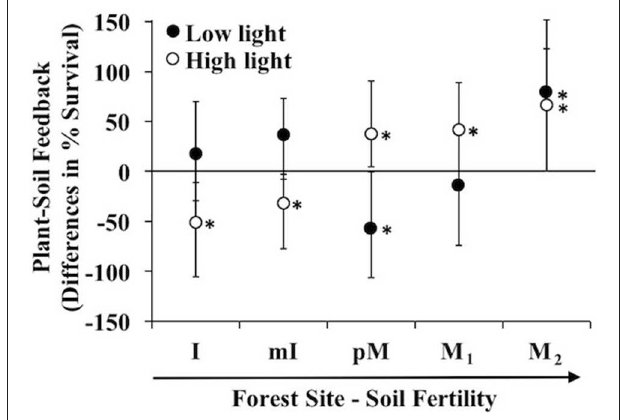
FIGURE 1 | Differences in predicted survival due to microbe mediated PSF (survival in conspecific vs. heterospecific non-sterile soil—survival in conspecific vs. heterospecific sterile soil) in a greenhouse experiment of Prunus serotina seedlings across 5 sites that range in soil fertility and community composition ( Tables 1 , 2 ) conducted under low and high light. Sites are in rank order of soil fertility from left (low) to right. Data are means with 95% credible intervals; credible intervals that do not overlap with the zero line are statistically significant. * P < 0.05.